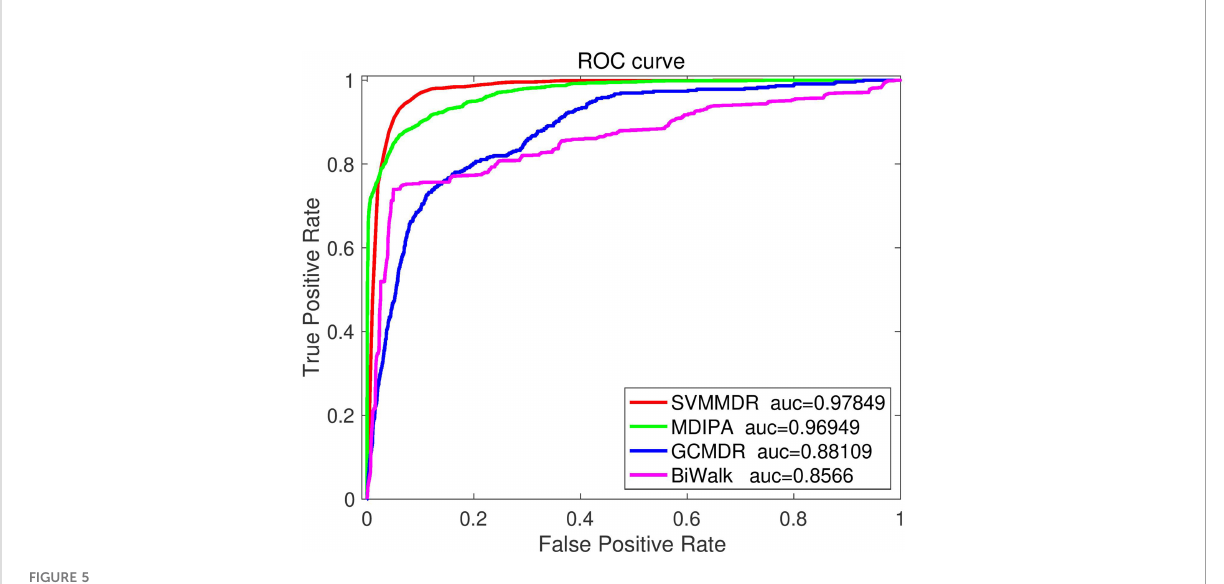
FIGURE 5 The ROC curve comparison with existing